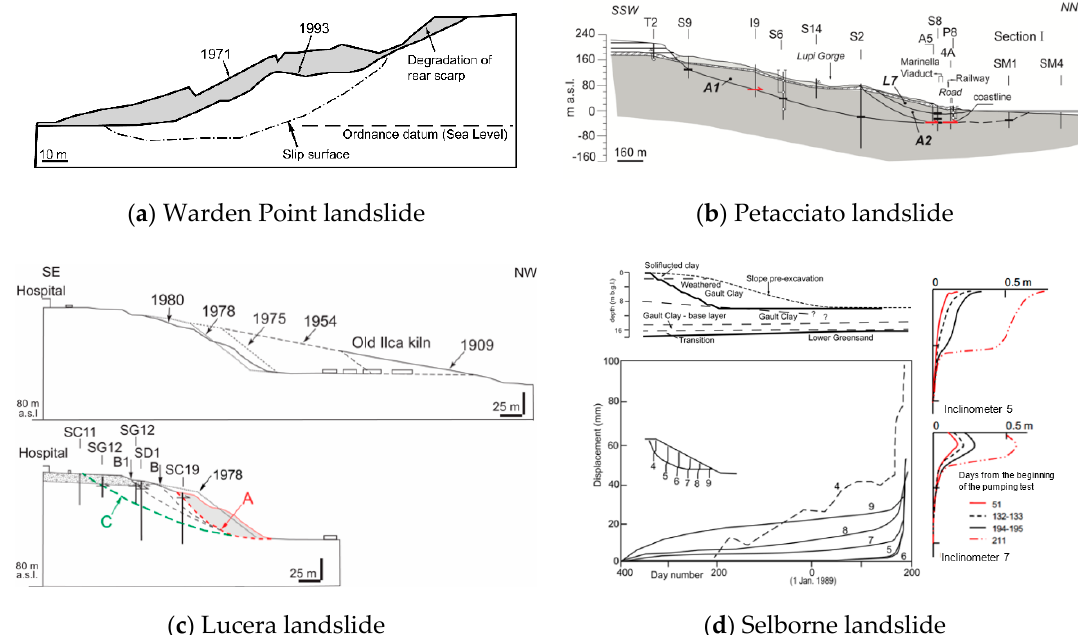
Figure 13. Some rototranslational landslides in stiff clays (class 1 in Figure 11; Table 3; modified from [79]—( a ) Warden Point landslide, [80]—( b ) Petacciato landslide, [38]—( c ) Lucera landslide, [83]—( d ) Selborne landslide).